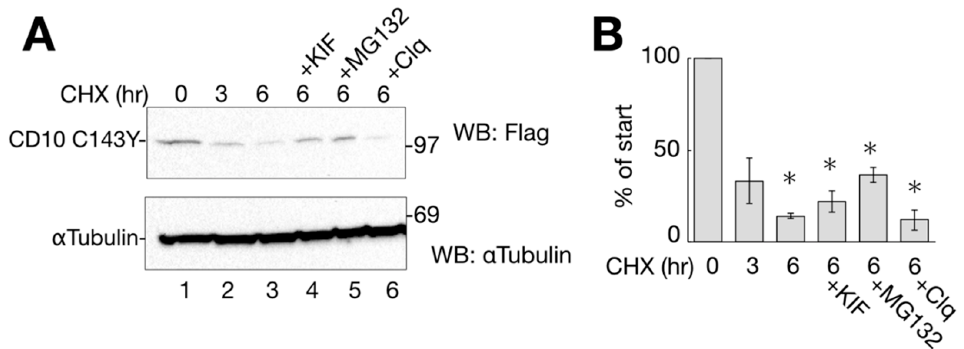
Figure 4. CD10 C143Y turned over shortly. ( A ), degradation of CD10 C143Y. HeLa cells transfected with CD10 C143Y-Flag were treated with cycloheximide (CHX) for indicated times with or without degradation inhibitors (kifunensine (KIF), MG132, or Clq; lanes 4–6). Upon treatment, cells were harvested, and immunoblotting with the indicated antibodies was performed. α -tubulin was used as the cellular loading control. ( B ), half-life of CD10 C143Y-Flag was measured for densitometric analysis of A. CD10 C143Y-Flag bands were normalized to that of α -tubulin as the total cellular protein. Asterisk refers to time 0 h ( p < 0.01) by Student’s t test. Error bars represent standard deviations for at least three independent experiments.